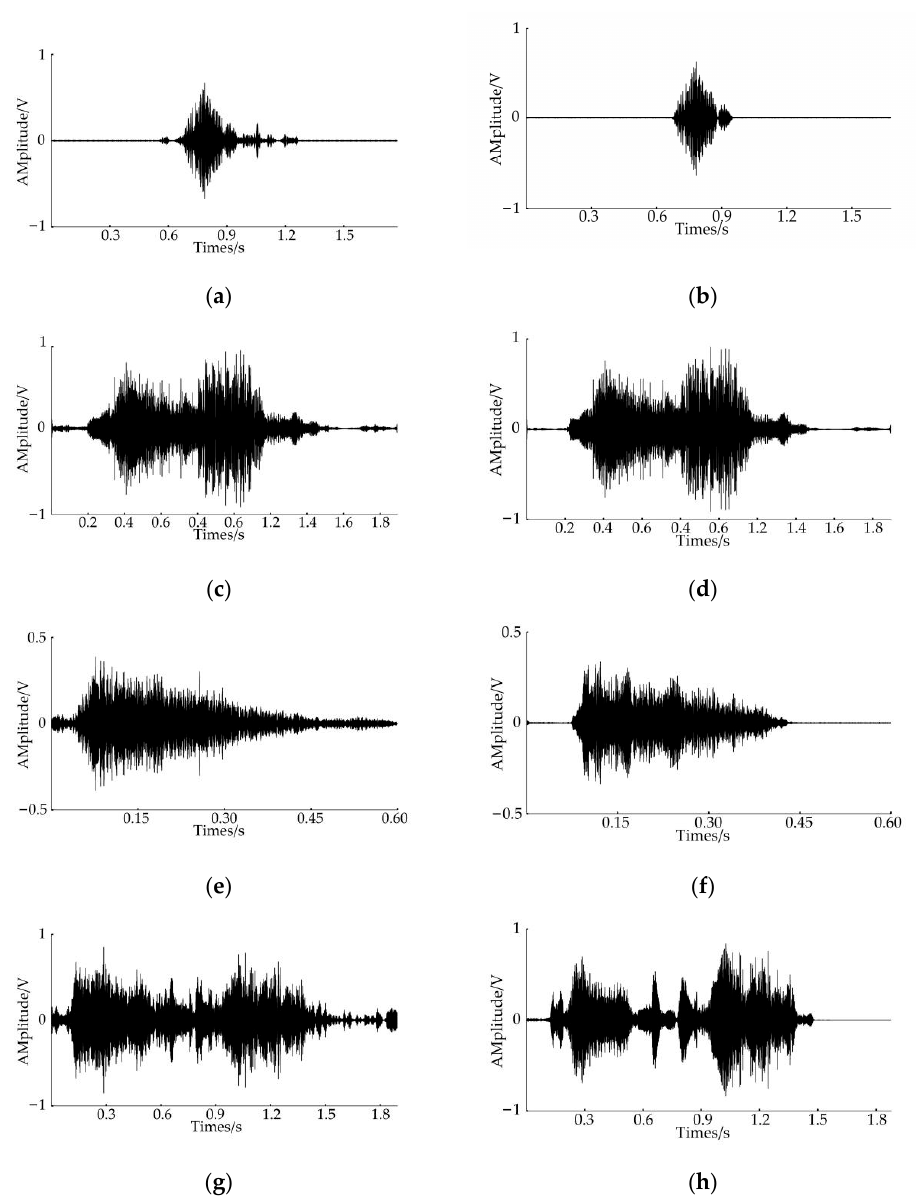
Figure 3. The comparison before and after speech enhancement based on spectral subtraction: ( a ) pig cough sound waveform before speech enhancement; ( b ) pig cough sound waveform after speech enhancement; ( c ) non-pig cough sound 1 waveform before speech enhancement; ( d ) non-pig cough sound 1 waveform after speech enhancement; ( e ) non-pig cough sound 2 waveform before speech enhancement; ( f ) non-pig cough sound 2 waveform after speech enhancement; ( g ) non-pig cough sound 3 waveform before speech enhancement; ( h ) non-pig cough sound 3 waveform after speech